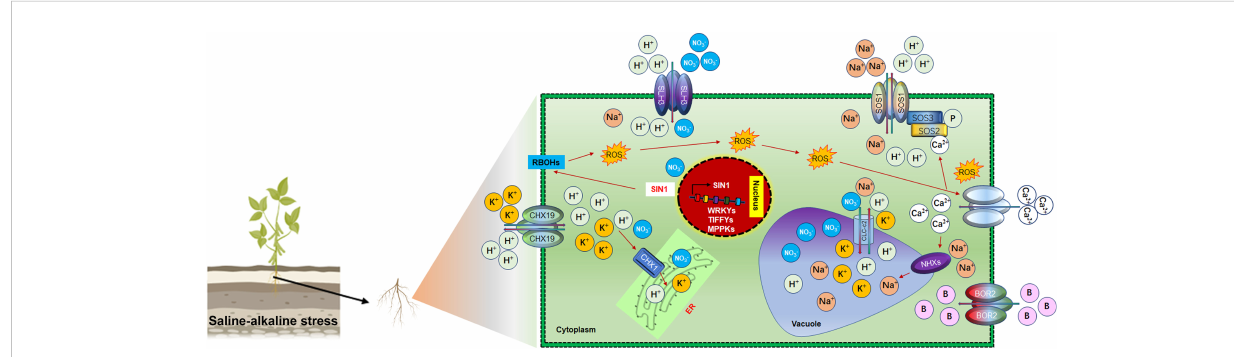
FIGURE 4 Ionic homeostasis regulation under saline-alkaline stress in Soybean Under saline-alkaline stress, different antiporters and cation exchangers are activated for ionic homeostasis. These transporters transduce ions by choice. For instance, SLH3 is responsible for H + and NO 3- , SOS1 regulate the bidirectional movement of Na + and H + ions, CHX19.3 transduce bidirectional movement of K + and H + into the endoplasmic reticulum (ER) for packaging and subsequently dispose of through budding process form cell. Activation of RBOH by the nuclear SIN1 gene caused the production of ROS. Stimulating the production of ROS under saline-alkaline stress leads to the activation of Ca 2+ channels to mediate the transduction of ions to the vacuole for storage. Interestingly, most of these regulatory pathways are involved in ionic homeostasis rather than pH regulation under saline- alkaline stress in